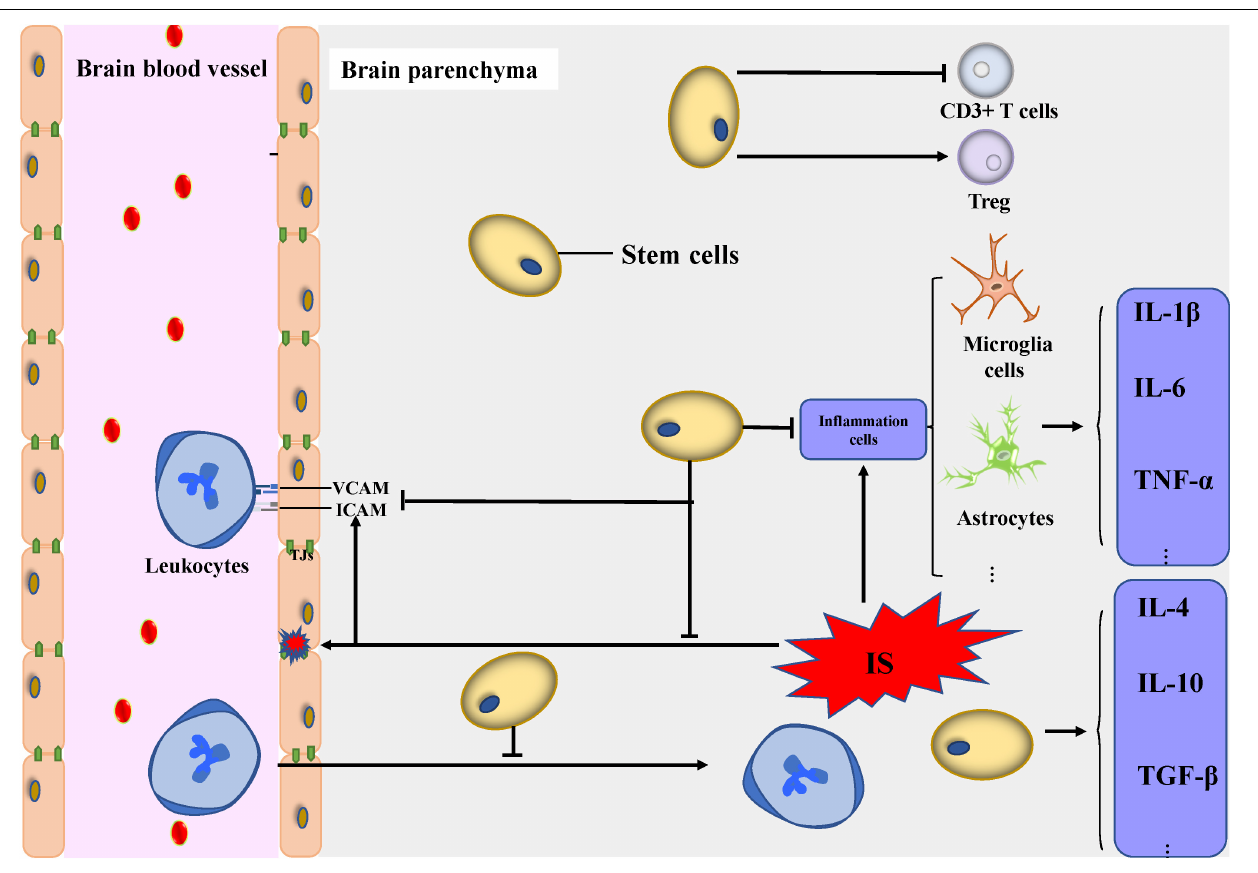
FIGURE 2 | Modulation of neuroinflammation and immune response. Transplanted stem cells can decrease the expression of pro-inflammatory cytokines including IL-1 β , IL-6, and TNF- α and secrete anti-inflammatory cytokines including IL-4, IL-10, and transforming growth factor- β 1. Transplanted stem cells can modulate the activity of inflammatory cells including microglial cells, astrocytes, and T cells. The infiltration and pro-inflammation effect of leukocytes from peripheral blood decreased under the administration of stem cells. Abbreviations: IS, ischemic stroke; VCAM, vascular cell adhesion molecule; ICAM, intercellular adhesion molecule; IL, interleukin; TNF, tumor necrosis factor; TGF, transforming growth factor; Treg, regulatory T cells; TJs, tight